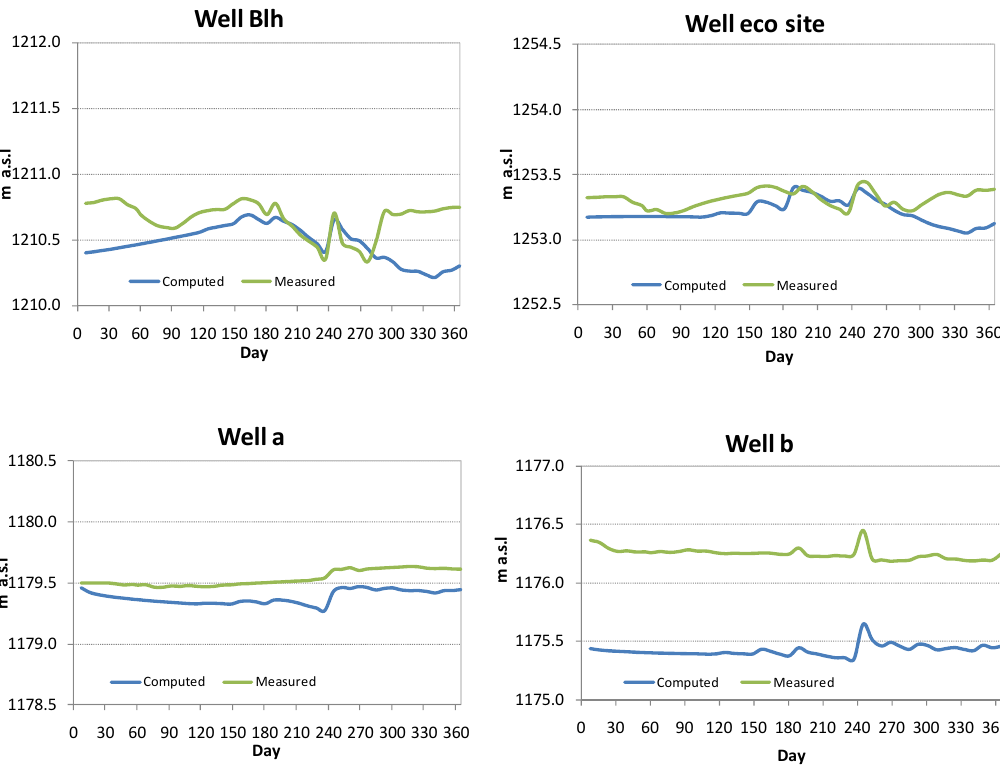
Figure 9. Fit of the computed groundwater levels to the measured ones in four wells in Bulang sub-catchment.